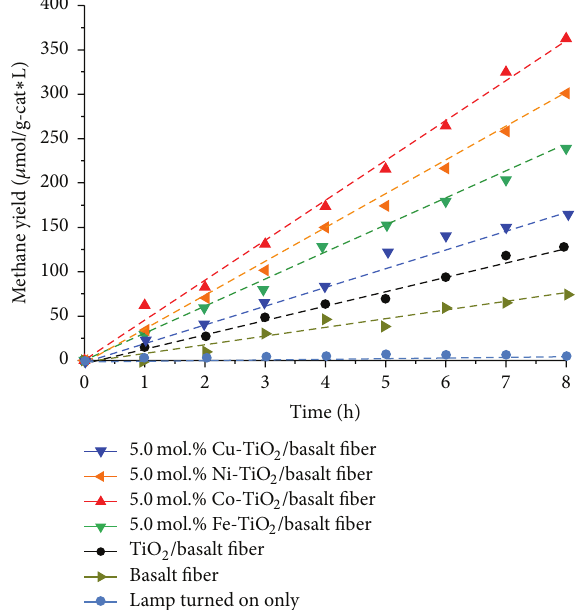
Lamp turned on Figure 10: Photoreduction abilities of CO 2 with H 2 O vapor to CH 4 over the pure basalt fiber film and 5.0 mol.% M-TiO 2 /basalt fiber films after 8